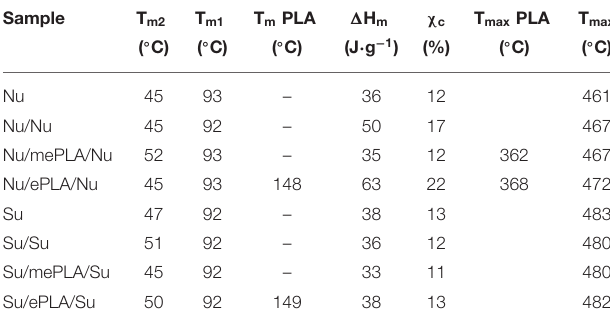
TABLE 1 | Thermal properties of all the processed samples.